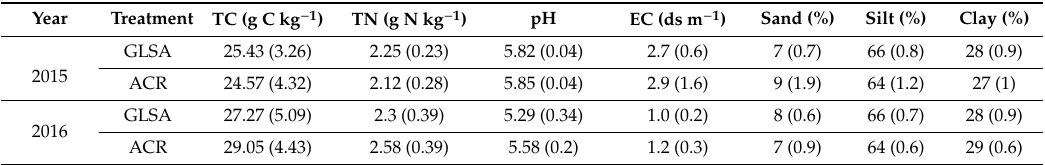
Note: Di ff erent letters indicate significant di ff erences ( p < 0.05). Table A2. Total soil carbon (TC), total soil nitrogen (TN), pH, electrical conductivity (EC), sand, silt, and clay at 0–15 cm depth taken at the beginning of 2015 and 2016 seasons. Statistical analyses were run but no di ff erences were found ( p < 0.05) between grassland set-aside (GLSA) and annual crop rotation (ACR) for any of these soil